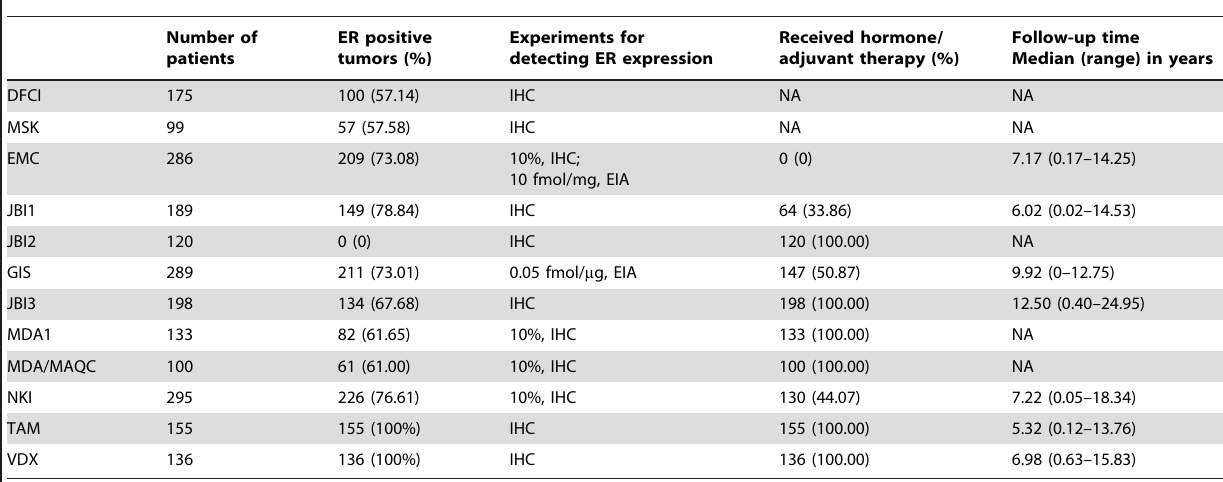
Table 1. Summary of breast cancer cohorts used in this study.